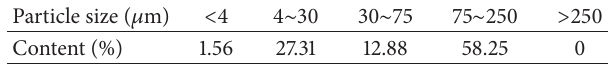
Table 3: Particle distribution of testing soil.